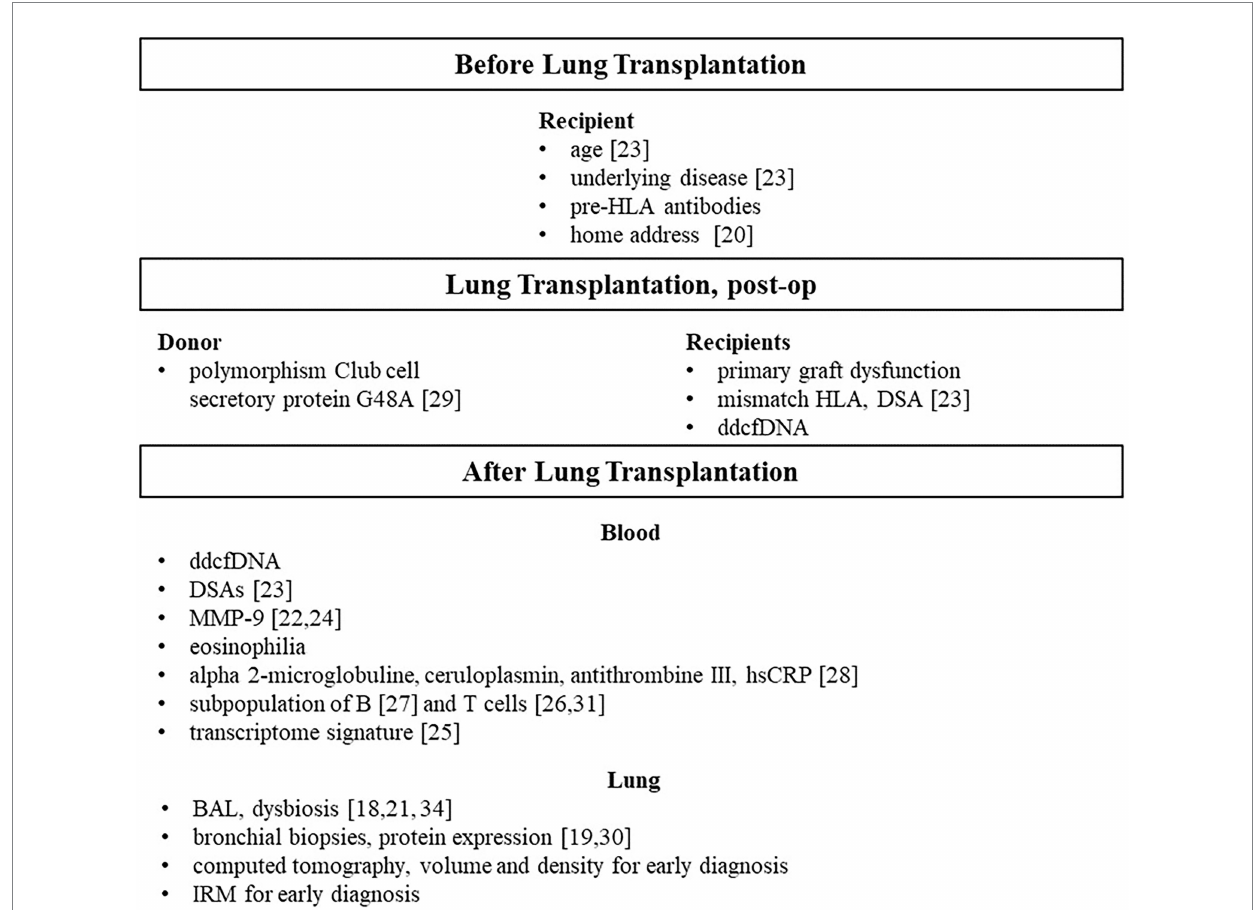
FIGURE 16 Predictive and/or early marker of CLAD after lung transplantation, main contributions of the COLT and SyCLAD cohorts, reference issued from our cohort